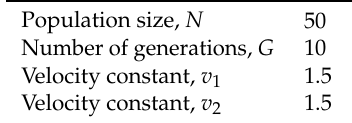
Table 1. Initialized value for selected parameters.